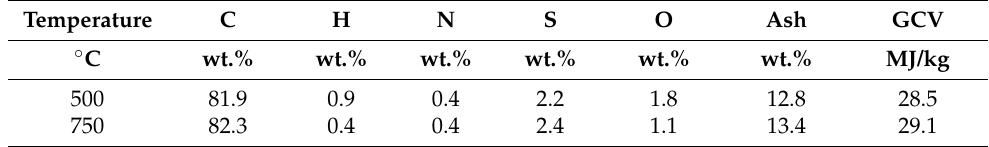
Table 3. Ultimate analyses, ash content, and gross calorific value (GCV) of the char obtained in waste tire pyrolysis.